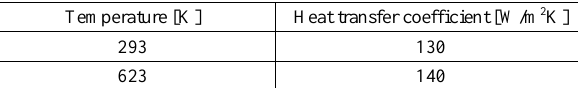
Fig. 8. Additional boundary Fig. 9. Additional boundary con- condition of the piston's thermal dition for the thermal load of the load – oil channel – temperature: piston – internal surfaces – tem- 373 K, heat transfer coefficient: perature: 393 K, heat transfer 2500 W/(m 2 K) coefficient: 500 W/(m 2